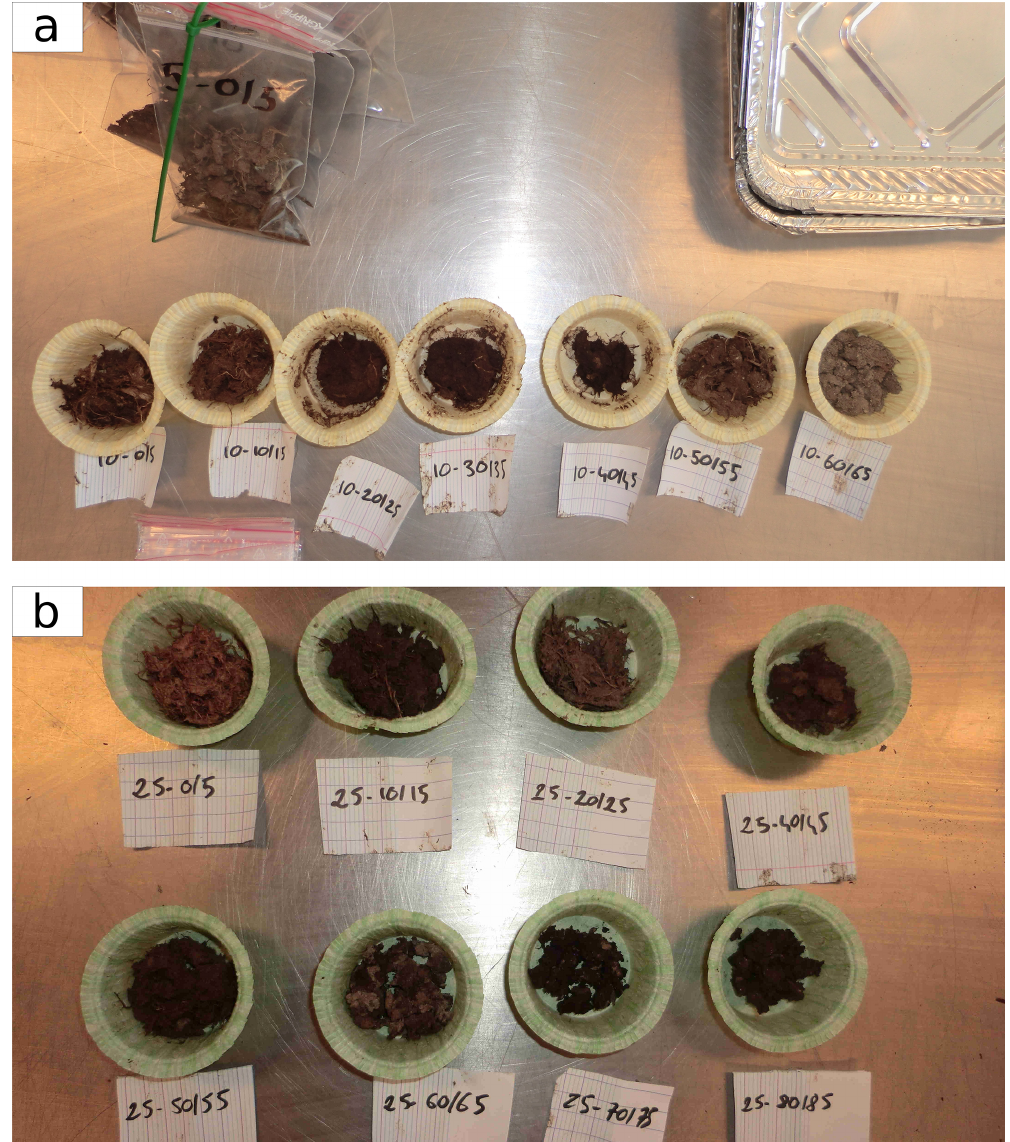
Figure 4. First transect soil samples after 48h of oven drying at 80 ◦ C. Different samples depths are shown for plots (a) T1–10 and (b)